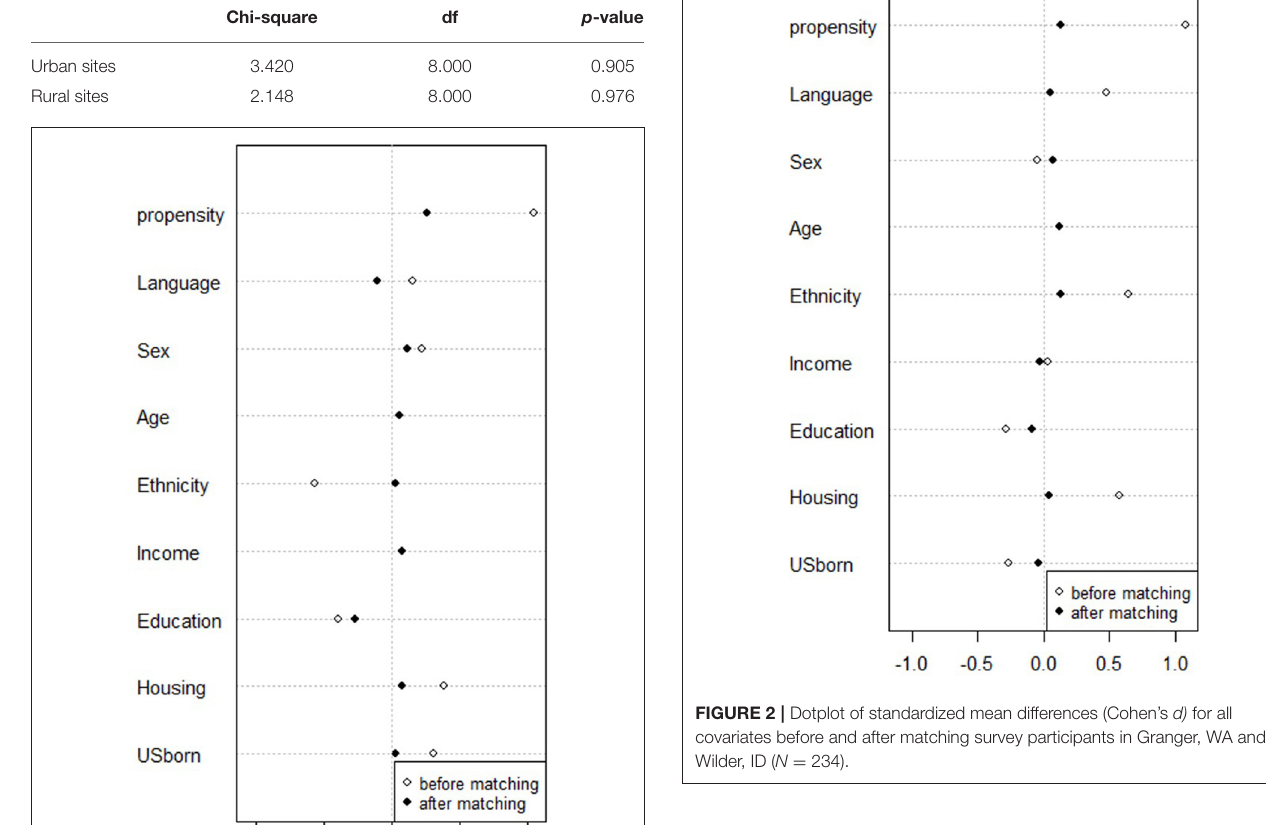
TABLE 3 | Propensity score matching results of the overall balance test (48) for the intervention and comparison groups.